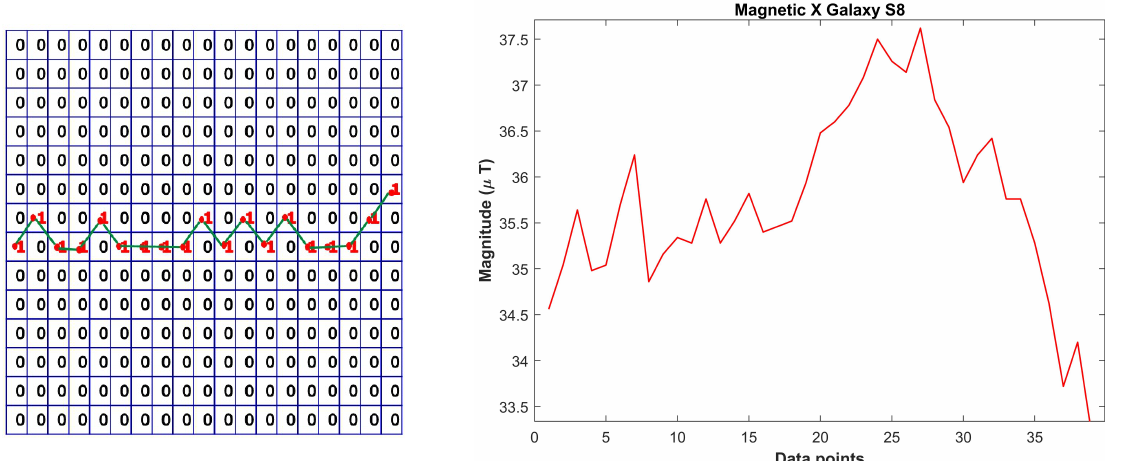
Figure 7. Sample binary grid for first 20 data points ( left ); and magnetic field data ( right